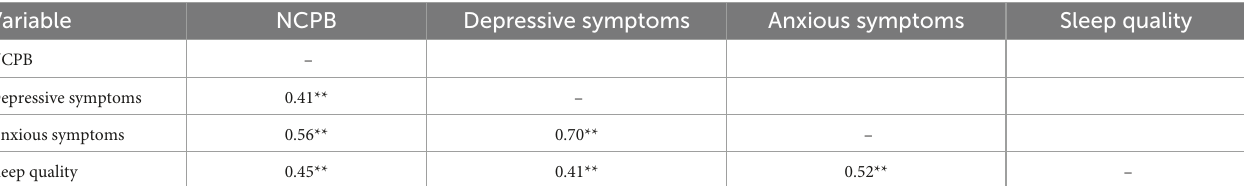
TABLE 1 Correlation among study variables ( r ).